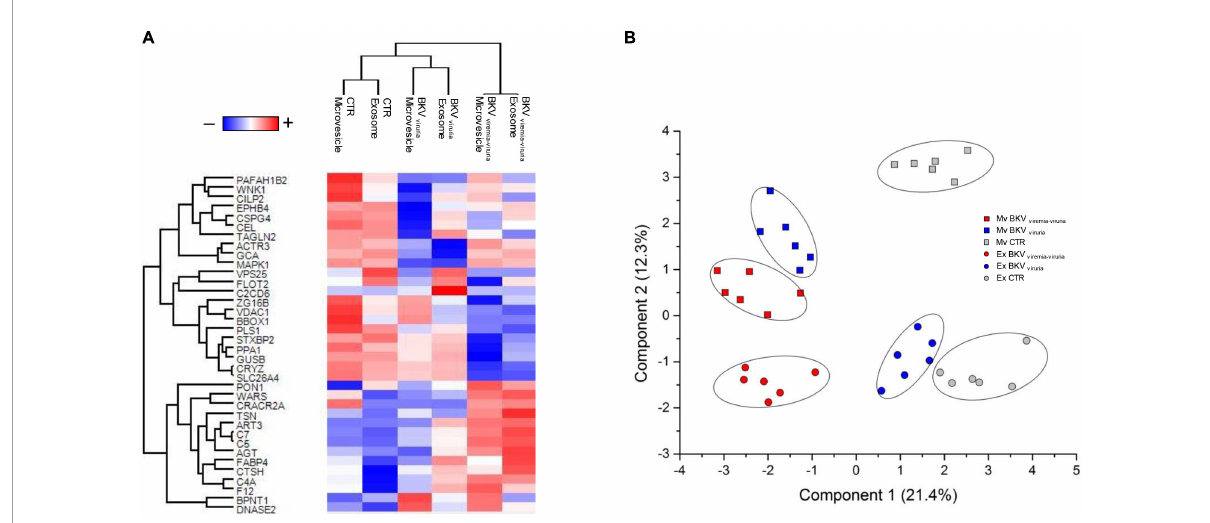
FIGURE6 Heatmap and partial least squares discriminant analysis (PLS-DA) of proteins that maximize the discrimination among all condition. (A) Heatmap, which depicts values for a main variable of interest across two axis variables as a grid of colored square, of 36 proteins identified through the combined use of univariate statistical analysis, machine learning and PLS-DA. In the heatmap, each row represents a protein, and each column corresponds to a condition. Normalized Z-scores of protein abundance are depicted by a pseudocolor scale with red representing up-regulation and blue indicating down-regulation. The dendrogram displays the outcome of unsupervised hierarchical clustering analysis, placing similar proteome profile values near each other. Visual inspection of the dendrogram and heatmap demonstrates the ability of these proteins to distinguish among the different conditions. (B) Two-dimensional scatter plot of PLS-DA of proteins maximizing the discrimination among all condition. Plot shows microvesicles (squares) and exosomes (circles) of CTR (gray), BKV viremia-viruria (red), and BKV viruria (blue) using the proteins identified by the combined use of t- test, SVM and PLS-DA. Ellipsis indicates 95% confidence interval. Visual inspection of scatter plot shows the ability of these proteins to clearly distinguish among the different